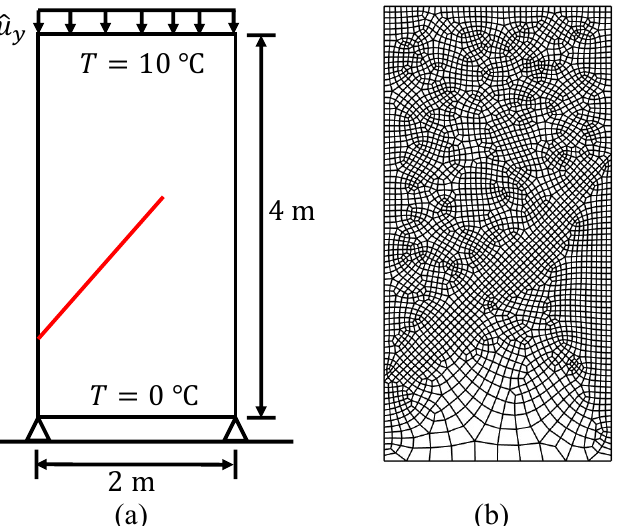
Figure 13. Problem description of the rectangle plate with an inclined crack: ( a ) geometry and boundary conditions; ( b ) unstructured FE